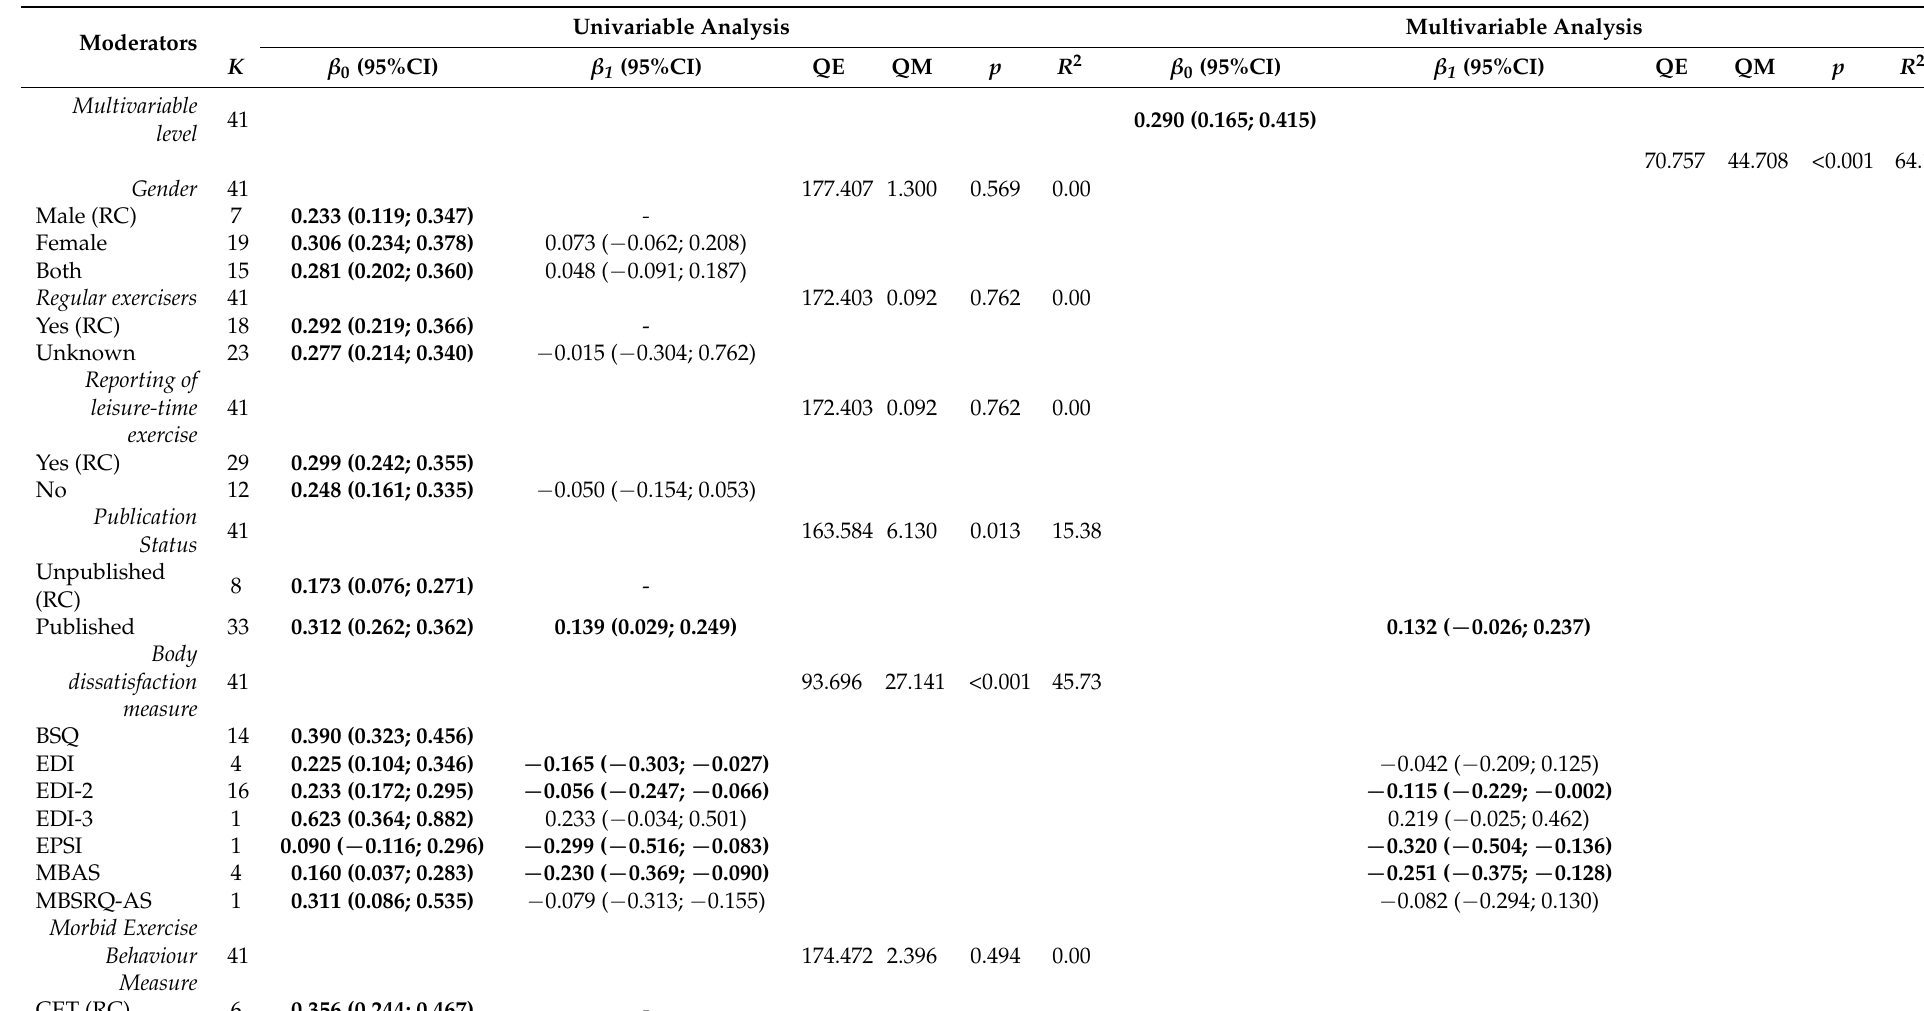
Table 3. Results of meta-regressions